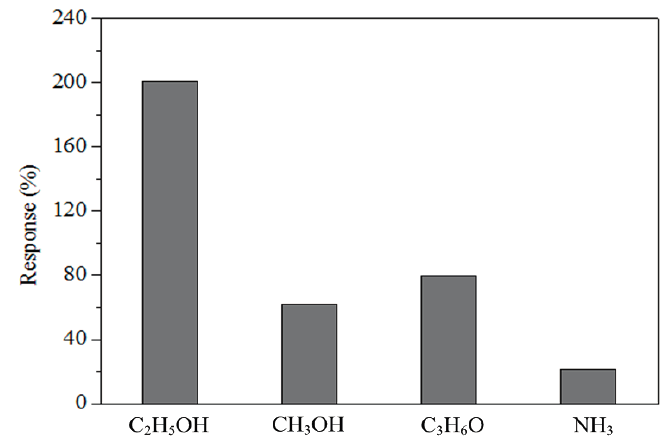
Figure 14. Response of the sensor under different